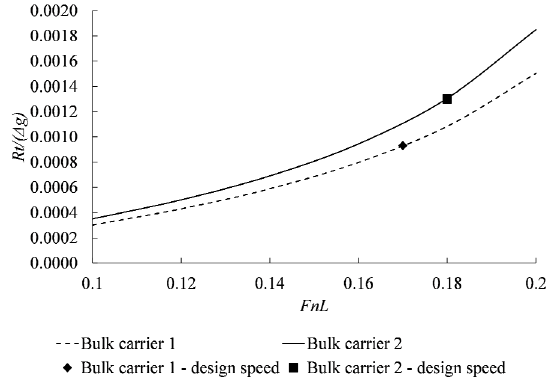
Figure 1. Non-dimensional total resistance vs. speed comparison